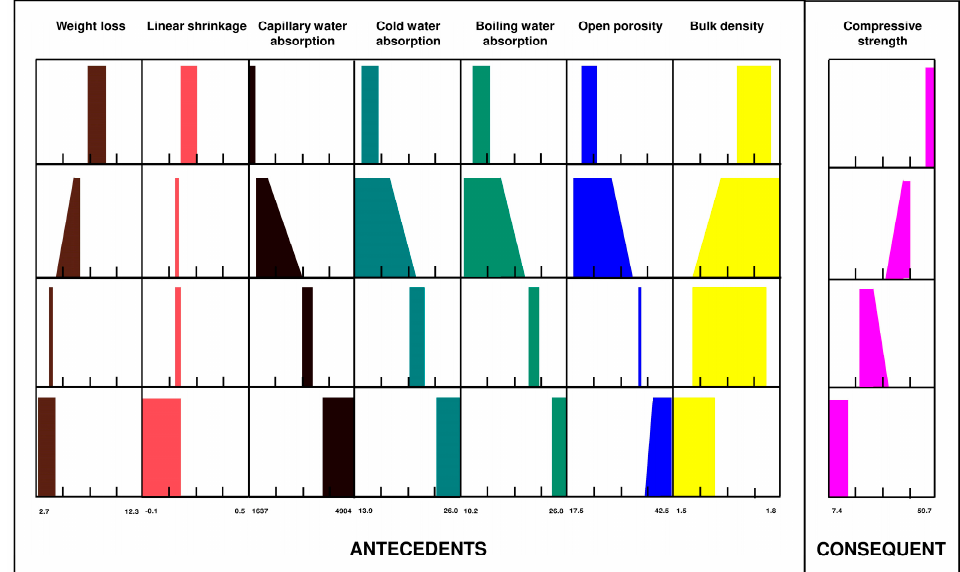
Figure 3. Fuzzy rules (compression strength as consequent).